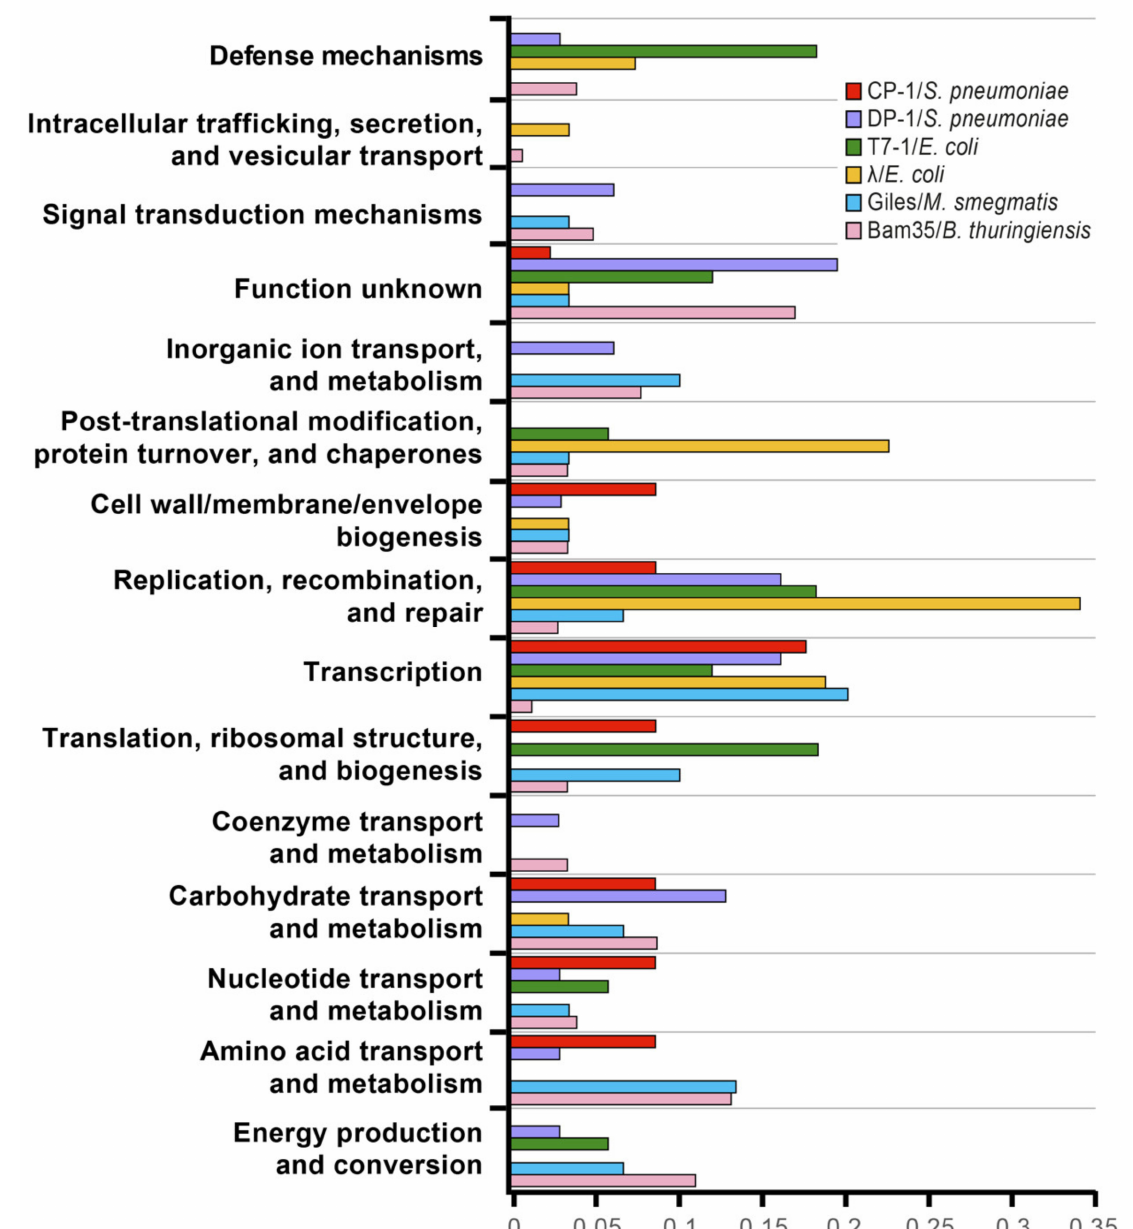
Figure 6. Frequency of phage-targeted proteins and their functional classes adapted from Mariano et al. [38]. The interactions between Giles and Mycobacterium smegmatis (blue) [39] and the interactions detected in this work between Bam35 and B. thuringiensis (pink) were